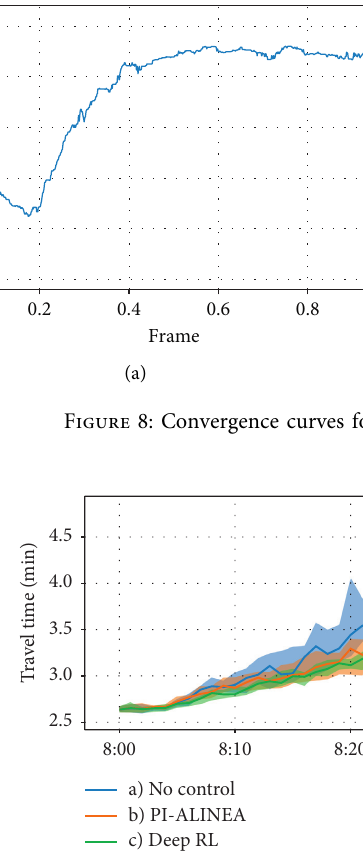
Figure 9: Vehicle travel times in the mainline.